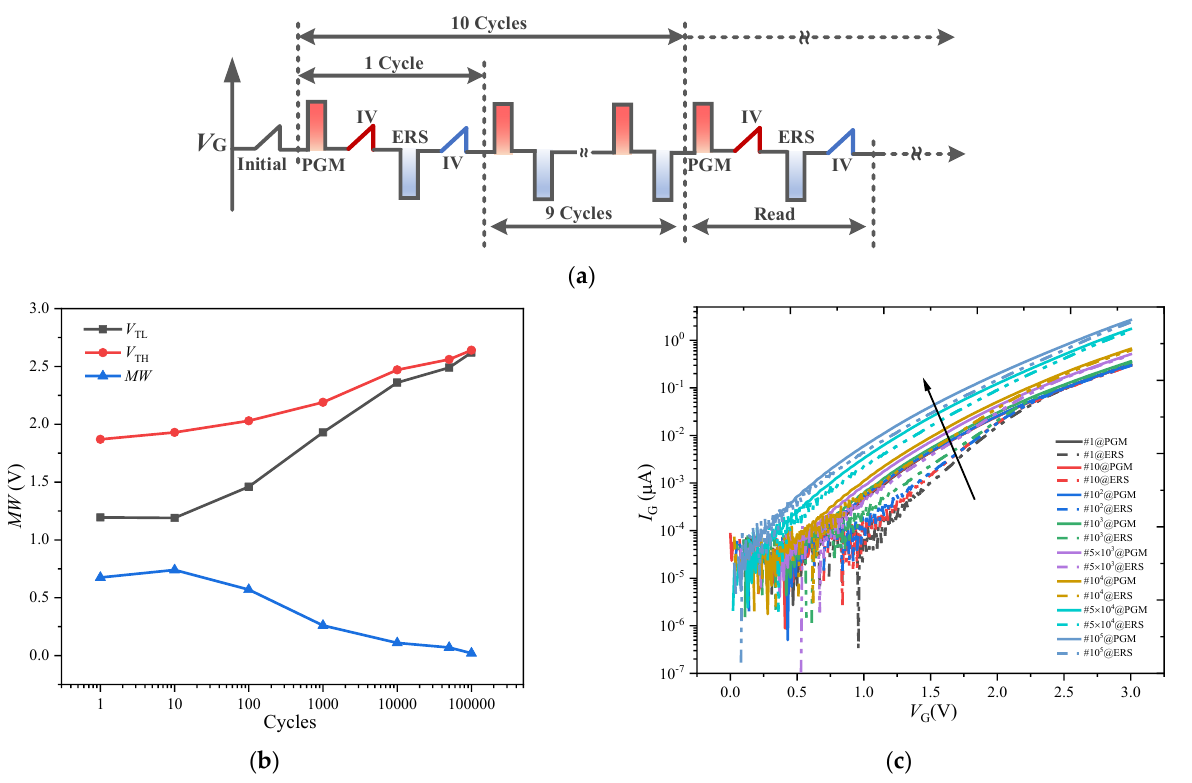
Figure 11. ( a ) Pulse sequence used for endurance measurements of the FeFET. ( b ) Variation of MW, V TH , and V TL with respect to cycles number. V TH and V TL increase with the increase in endurance cycles, the MW disappears at 10 5 cycles. ( c ) I G - V G curves under various endurance cycles, where the black arrow indicates that the gate current increases with the number of endurance cycles